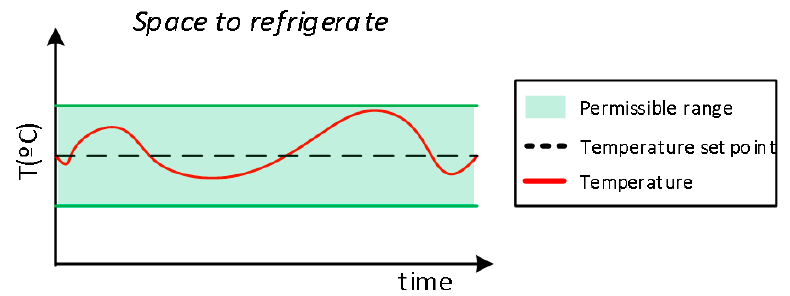
Figure 5. Example of the permissible temperature range of a specific space to refrigerate.